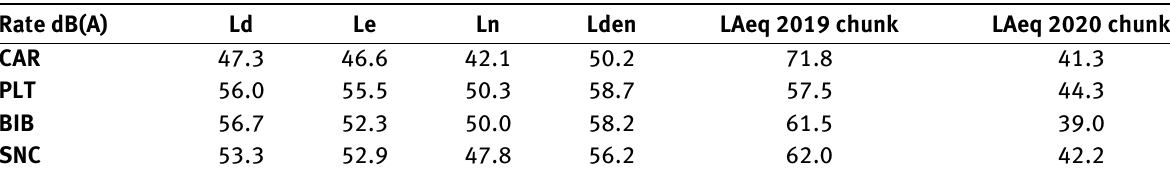
Table 6: Granada 2016 Strategic Noise Map yearly average noise indices values at selected sites together with LAeq from 2019 and 2020 short time measurements